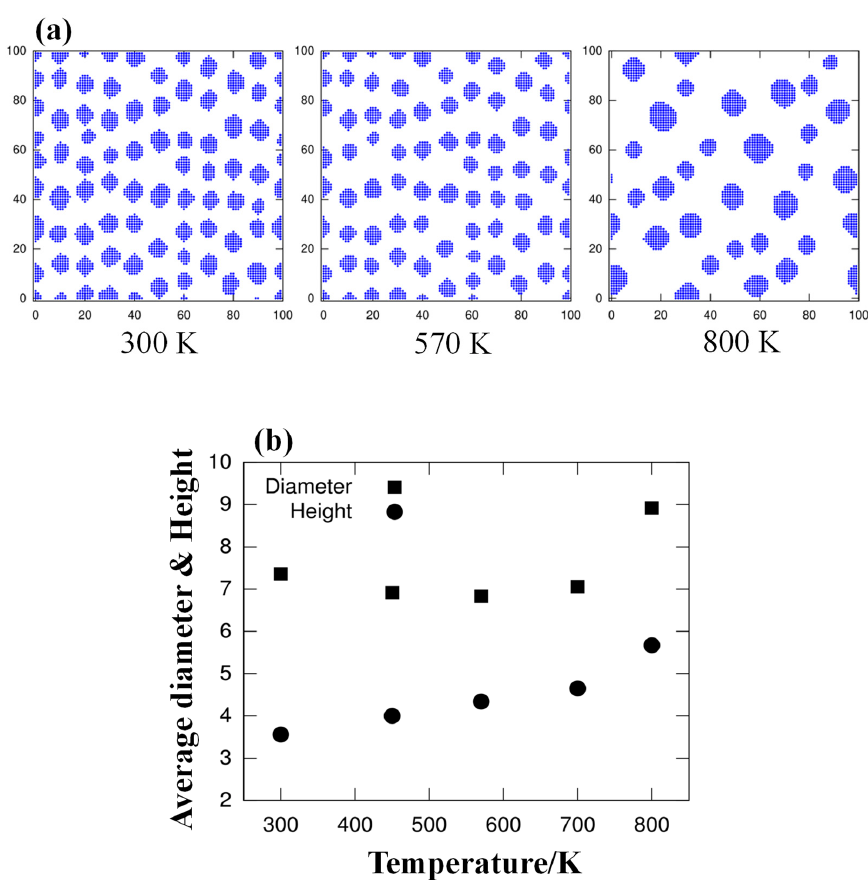
Figure 5. ( a ) Top view of the simulated configurations of Rh islands grown at 300 K and annealed to 570 and 800 K, as indicated. The lattice has 100 × 100 sites for each layer and the bonding energy (cid:15) is set as e − (cid:15) / kT = 0.01 for 300 K; the step count between each added atom is M = 10, the substrate defect binding parameter h = 3 and the coverage is 1.0 MLe. ( b ) plot of average diameter and height of simulated Rh islands as a function of temperature. The Rh islands were grown at 300 K and annealed to the temperatures as